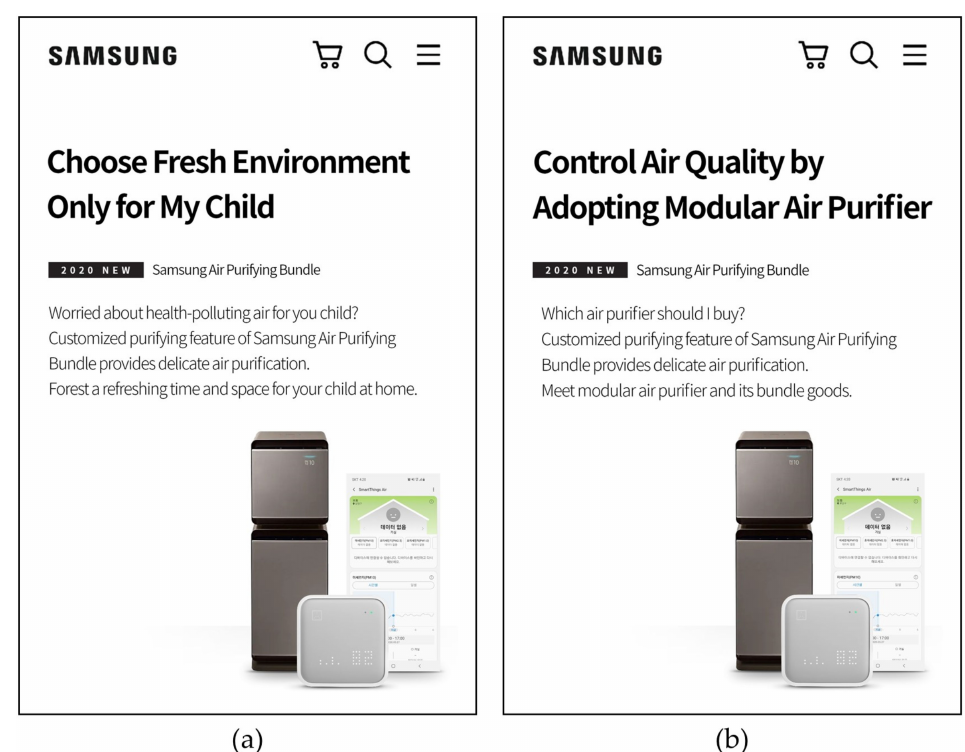
Figure 3. Study 2 stimuli ( a ) with-goal condition; ( b ) without-goal condition. Procedure: After carefully reading the first product description page,